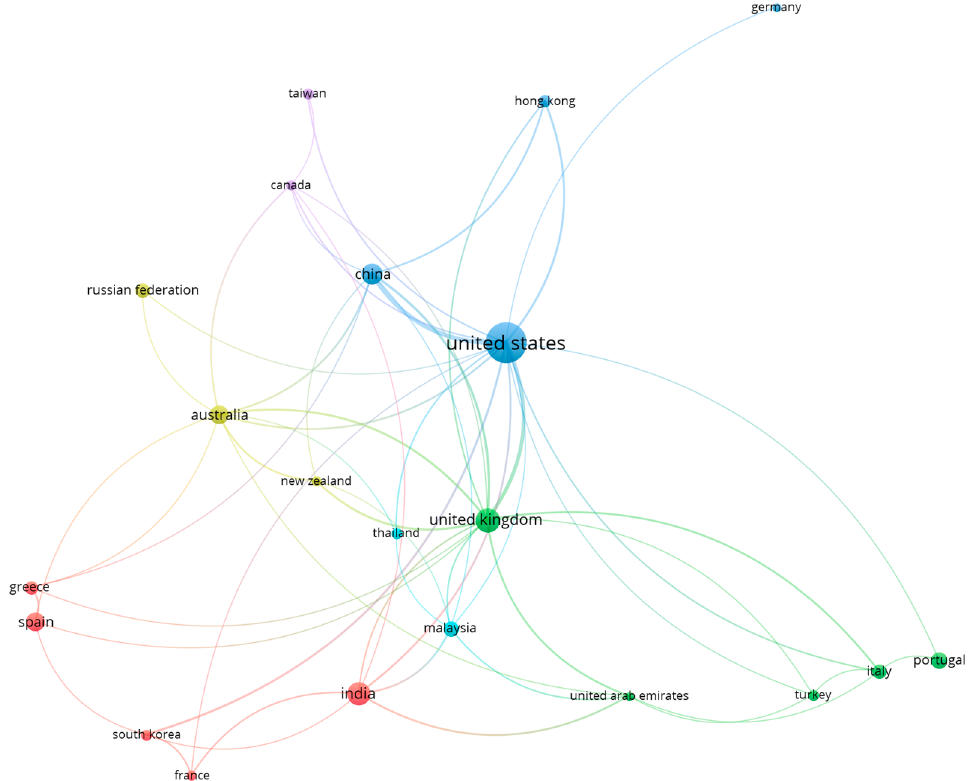
Figure 2. Visualization of the co-authorship of countries analysis.